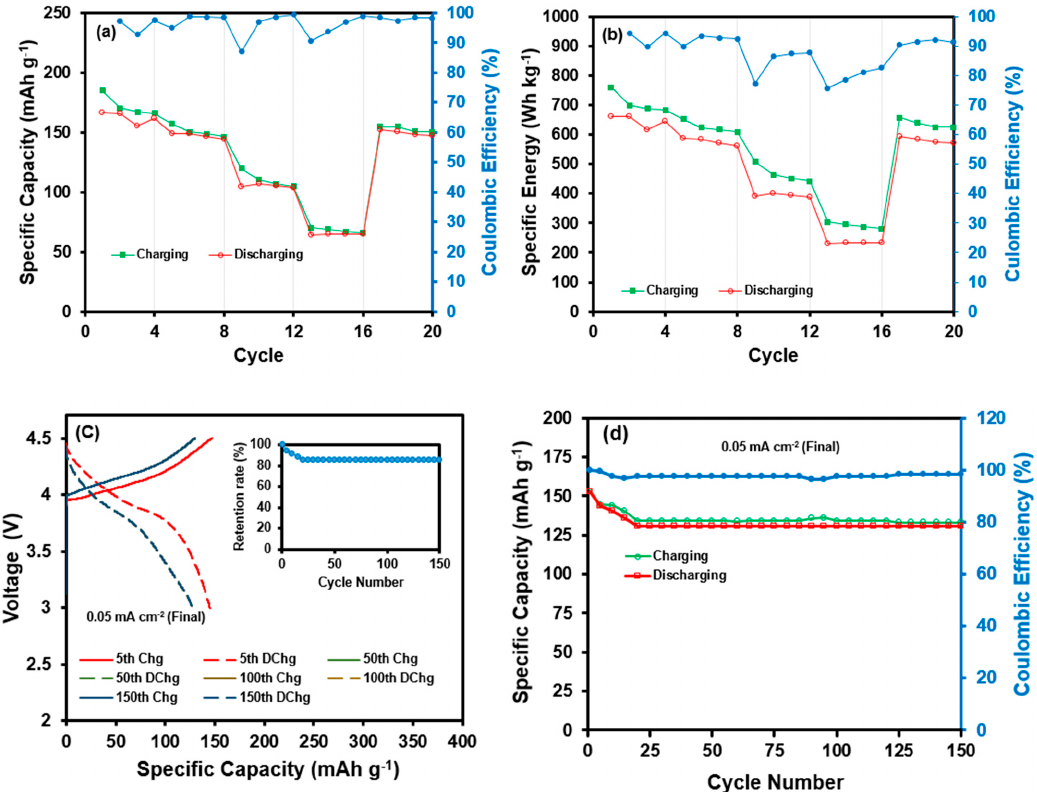
Figure 9. Electrochemical performance of LiCoO 2 |LLCZN/PEO/LiPF 6 |Li cells with voltage window of 3–4.5 V during the first 20 cycles at different currents: ( a ) specific capacity cycling performance; ( b ) specific energy cycling performance; ( c ) charge–discharge curve at 0.05 mA cm − 2 for selected cycles; ( d ) cycling Table 1. Cycle range for different currents, current densities expressed in terms of area and mass.